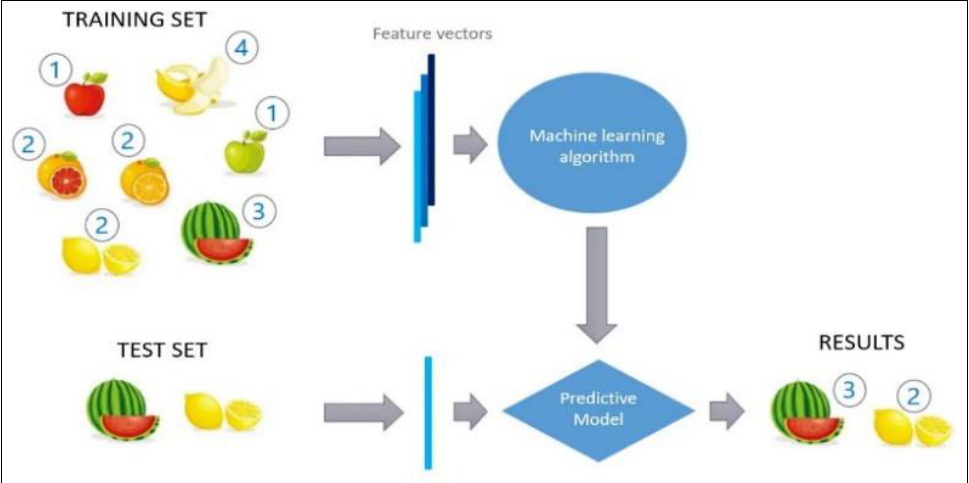
Figure 1: Supervised Learning Diagram.